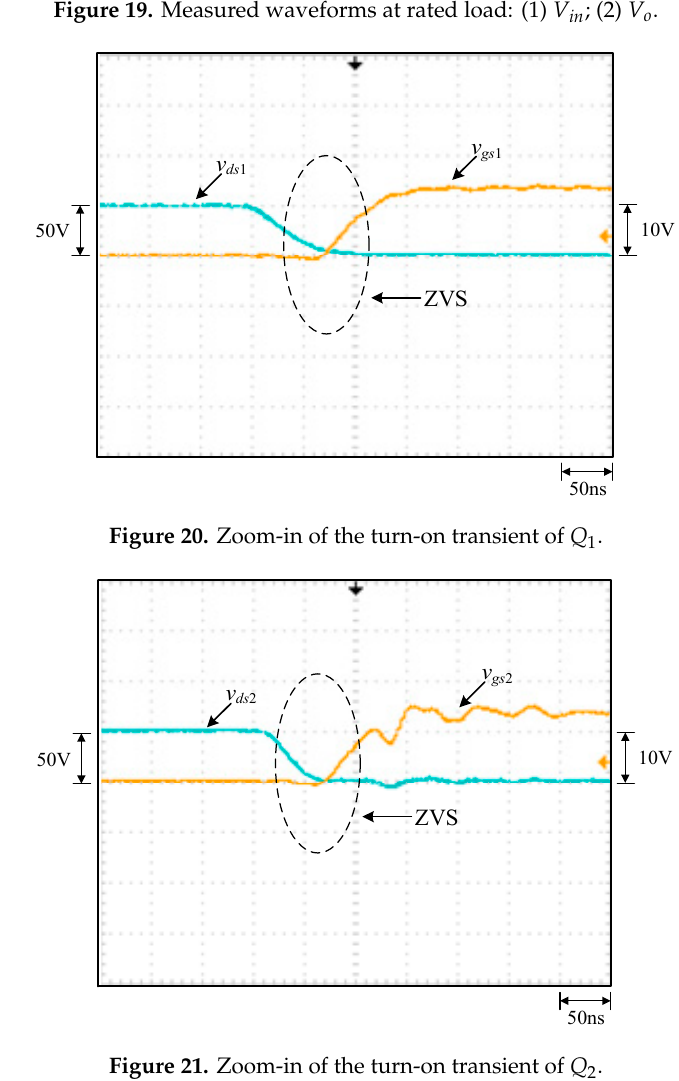
Figure 22. Output voltage responses due to load transients from light/rated load to rated/light load.